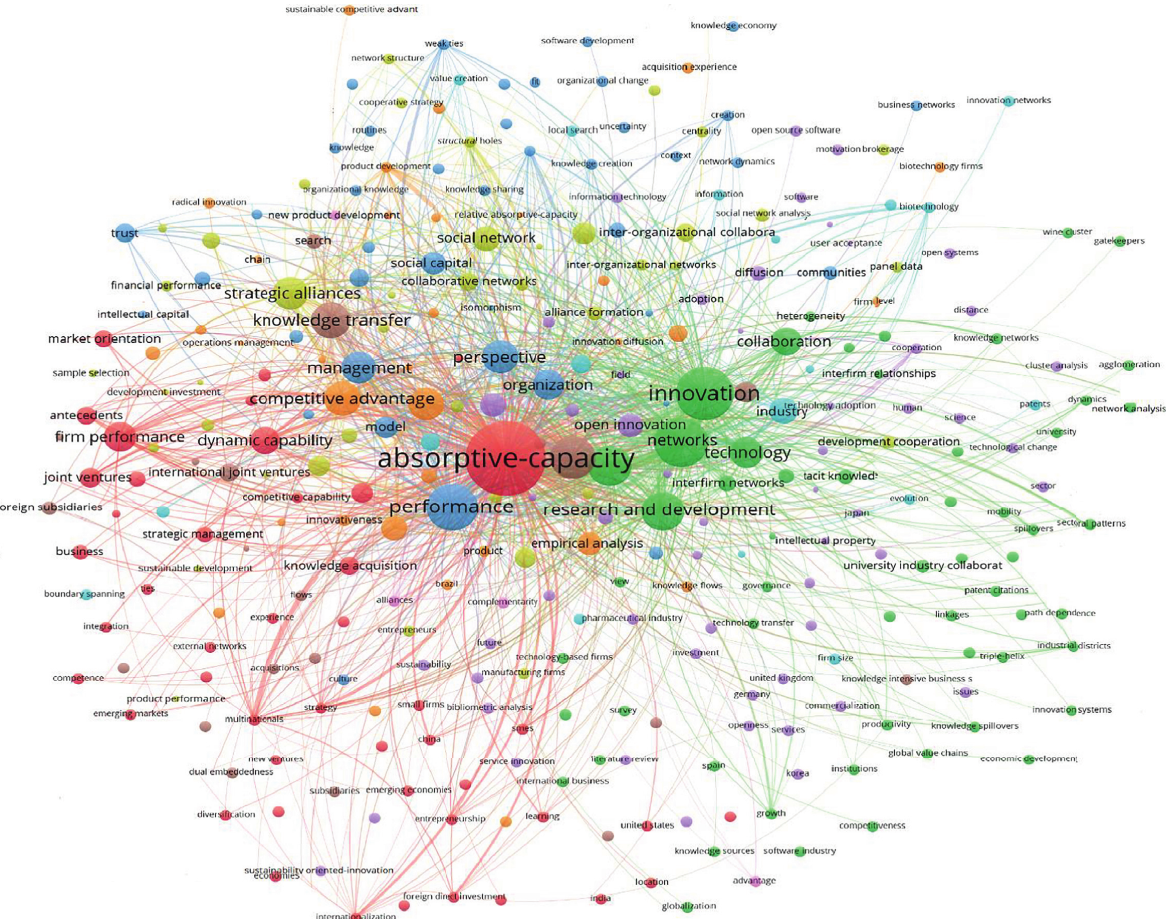
Figure 11: Keywords network. Source: own elaboration with Web of Science and Scopus data (2018) processed with VOSviewer software.